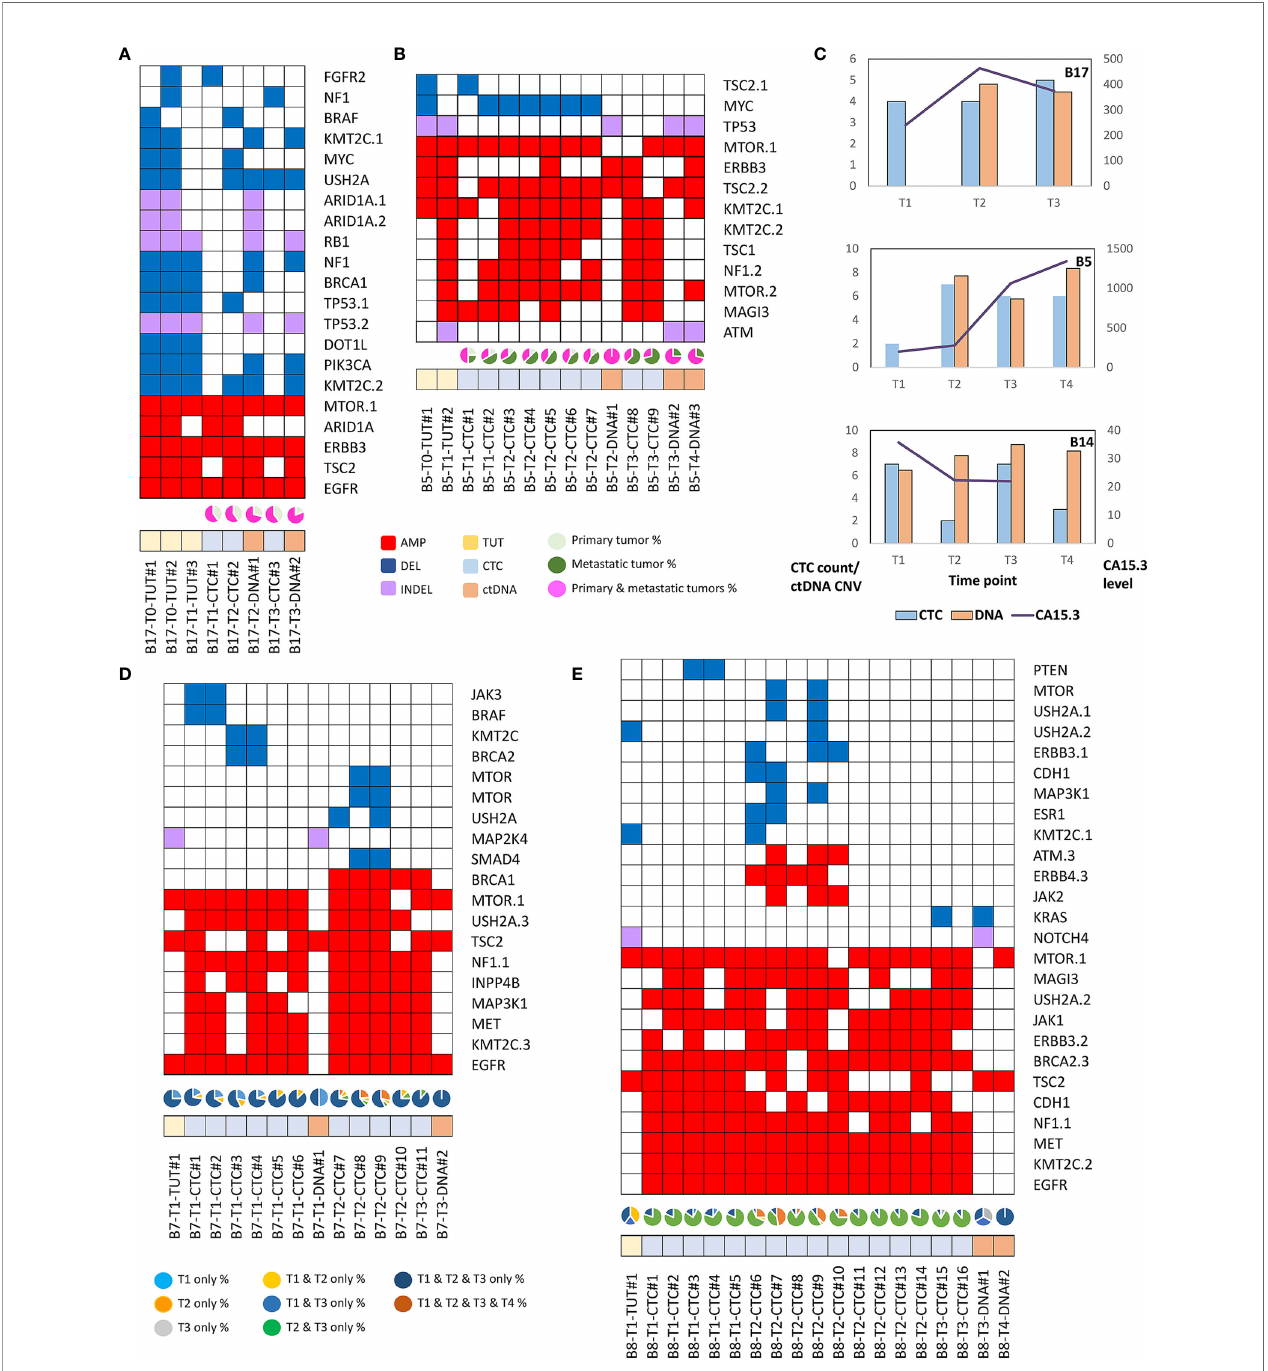
FIGURE 5 | The mutation pro fi les and evolving genomics alteration in CTCs, ctDNA, primary and metastatic breast tumors. Red rectangles represent ampli fi cations. Blue rectangles represent deletions. Green rectangles represent missense, Stopgain or Stoploss somatic SNVs. Purple rectangles represent somatic INDELs. TUT, CTC and DNA refers to tumors (yellow rectangles), individual CTC (blue rectangles) and ctDNA (orange rectangles) respectively. (A) Breast cancer patient, B17 with homogenous mutations pro fi le in the primary (T0) and metastatic (T1) tumors. The pie chart represents the fraction of detected mutations to the primary tumor (light green) or metastatic (dark green) tumor or both tumors (pink). (B) Breast cancer patient, B5 with heterogenous mutations pro fi le between primary and metastatic tumors. CTCs and ctDNA displayed better resemblance to metastatic than the primary tumors. (C) The CTC count, ctDNA CNV and CA15.3 level of serially collected samples for B5, B14 and B17 patients. (D) Majority of the mutations are consistently found at different time points in B7 breast cancer patient. However, selected mutations were only found in certain time points. The pie chart represents the fraction of detected mutations found at different time points. (E) Evolving genomics alterations during different course of treatment such as emergence of JAK2, ATM and KRAS